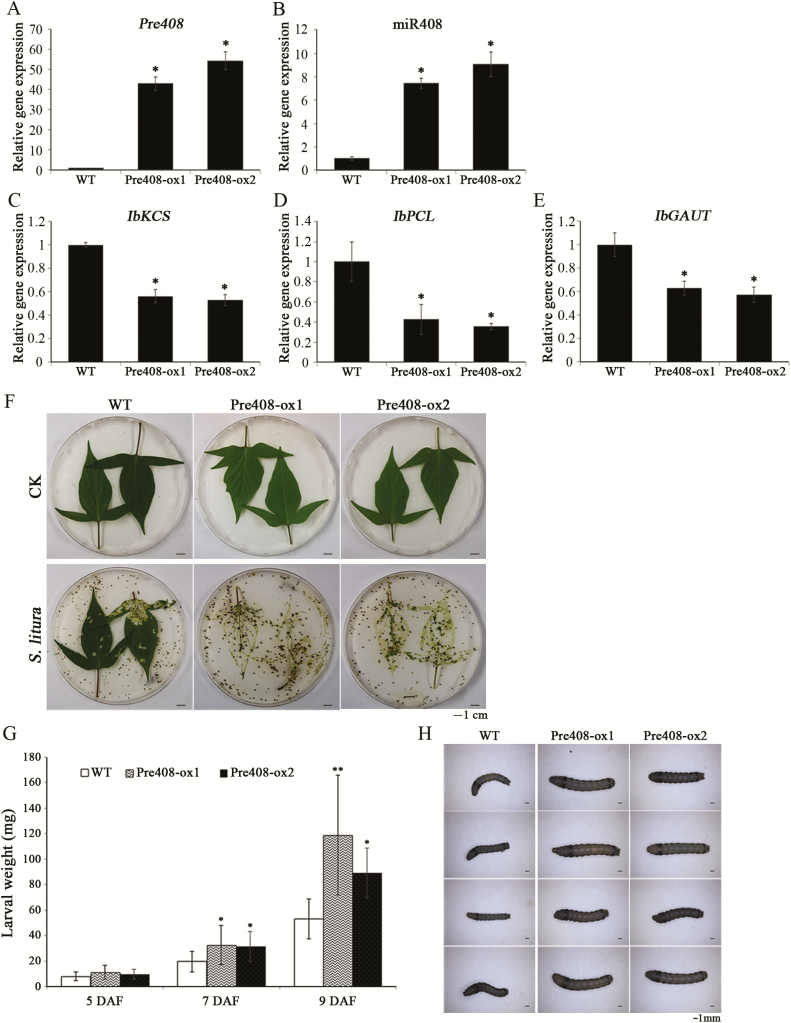
Gene expression and insect resistances of sweet potato overexpressing miR408. Expression levels of pre408 (A), miR408 (B), IbKCS (C), IbPCL (D), and IbGAUT (E) in wild-type (WT) and miR408-overexpressing (Pre408-ox1 and Pre408-ox2) sweet potato were analyzed by qRT-PCR. Sweet potato leaves were wounded by tweezers for 120 mins. The expression level of 5.8S rRNA was used as an internal control for miR408 expression. IbACT expression levels were used as internal controls for pre408 and miR408 target expression. Data are presented as means ±SD (n=4). The asterisks represent a significant difference by Student’s t-test (*P<0.05). (F) Representative leaves of WT, Pre408-ox1, and Pre408-ox2 sweet potato before (CK) and after feeding with S. litura. (G) Body weights of the second-instar larvae fed WT or transgenic plants were measured at 5, 7, and 9 d after feeding (DAF). Data are presented as means ±SD (n≥10). The asterisks represent a significant difference between WT and miR408-ox plants by Student’s t-test, *P<0.05; **P<0.01). (H) Representative images of the larvae fed WT or miR408-ox plants after 9 d.